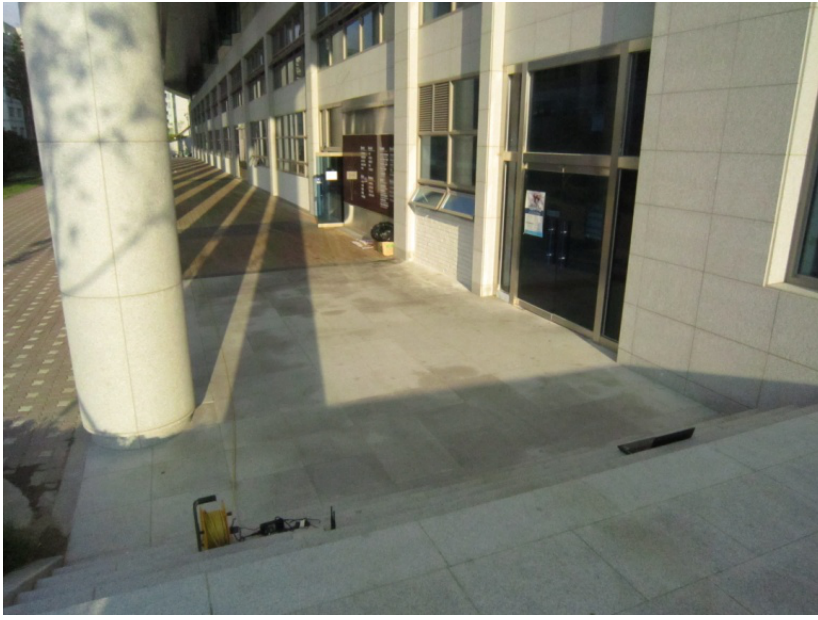
Figure 6. Photo of the actual field test where ( left ) MP1 and ( right ) station 1/laptop are